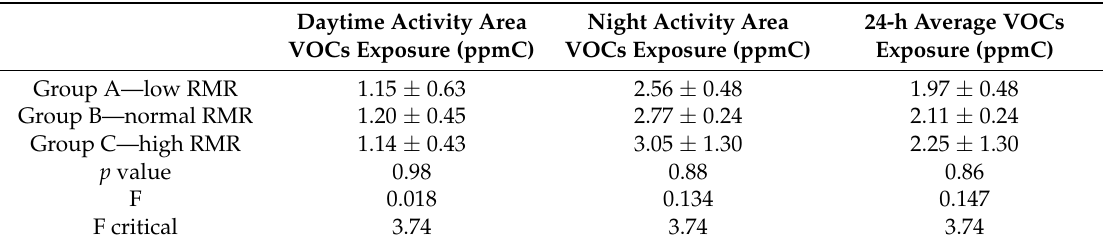
Table 3. Average VOCs exposure in sedentary office workers and ANOVA analysis.